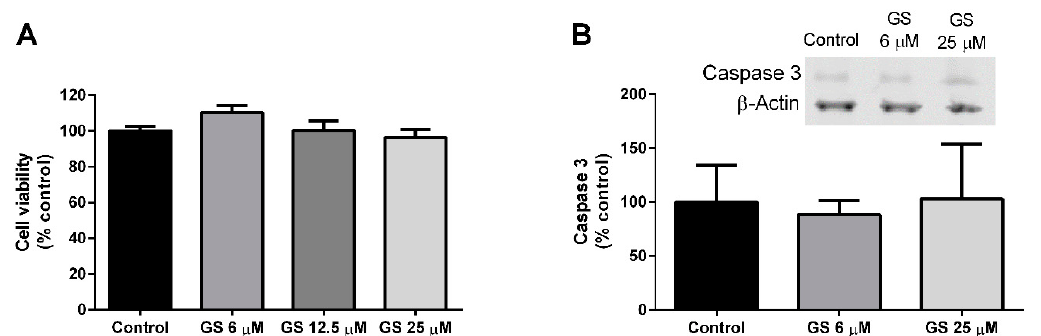
Figure 2. GS treatment does not impact viability of 3T3-L1 adipocytes. GS treatment for 24 h in mature, 3T3-L1 adipocytes has no effect on cell viability ( A ) or apoptosis as measured by caspase 3 ( B ). Data presented as mean ± SEM from n = 3–6 replicates per group.